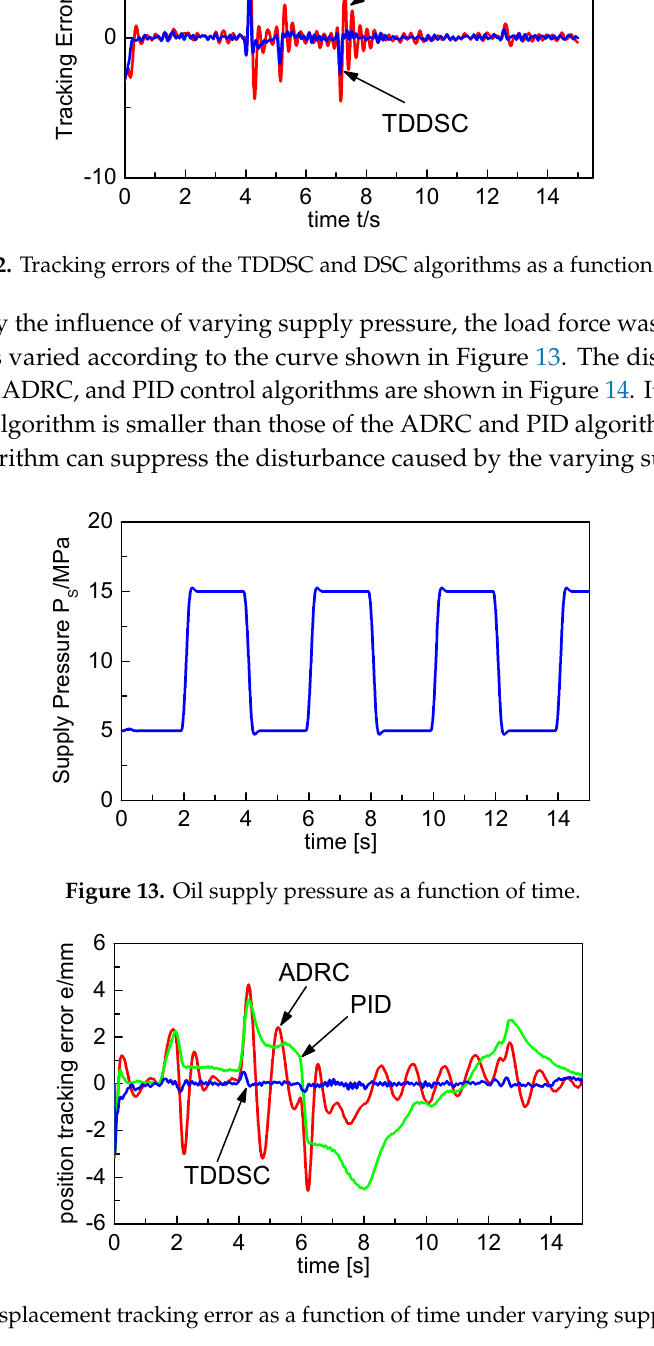
Figure 15. Rod chamber pressure as a function of time. 5.3. Analysis of the Energy-Saving Characteristics In order to analyze the energy-saving characteristics of the VSP-SMEHSS proposed in this paper, further experiments were carried out to compare the energy consumptions of the EHSS and the VSP-SMEHSS. The EHSS consisted of a pressure-compensated pump, a servo valve, and a hydraulic cylinder. The output pressure of the pump was adjusted to 15 MPa. The supply pressure, the pressures of the two hydraulic chambers, and the load force of the VSP-SMEHSS and the EHSS are shown in Figures 16 and 17, respectively. 0